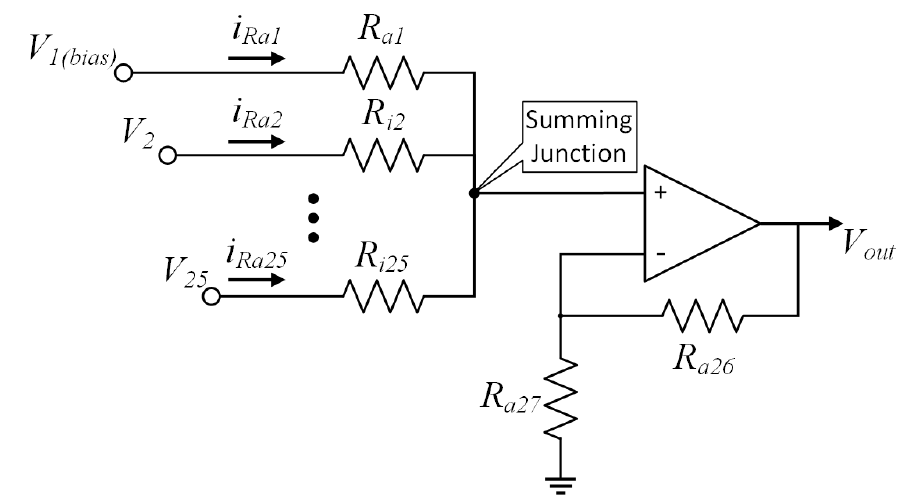
Figure 5. The equivalent circuit of Hopfield neural